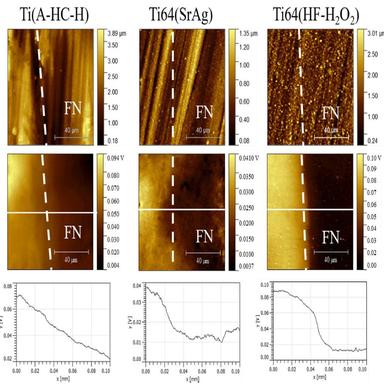
KPFM images of samples after fibronectin adsorption on a portion of the surface: topographical image (first row); surface potential image (second row); potential profile along the white line (third row). Dashed lines separate areas without (left of the line) and with (right of the line) the fibronectin layer.